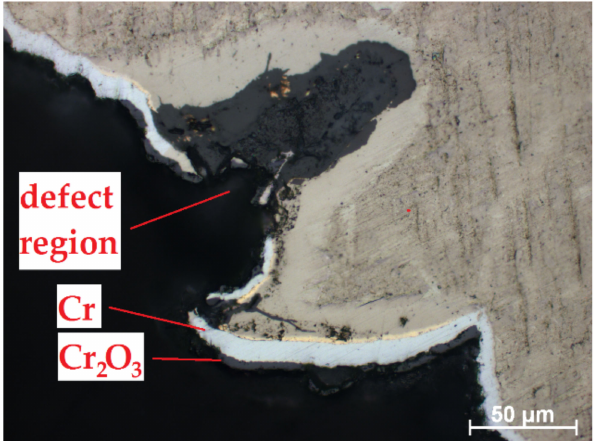
Figure 10. Oxidation of Cr-coated RUW weld in a weld burr